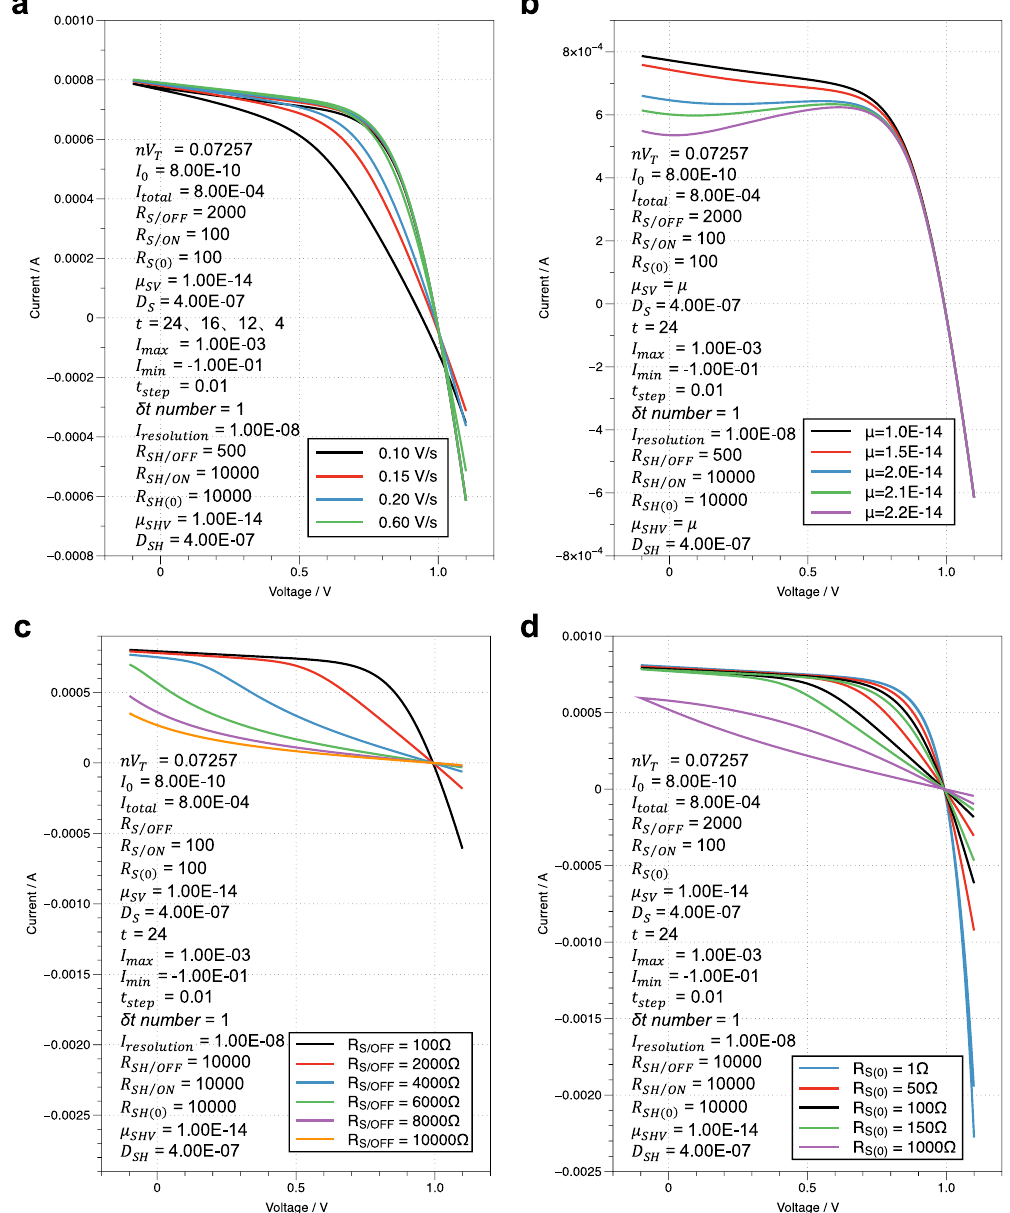
Figure 4. ( a ) The simulated/computed results of the dependence of the I–V characteristics of PSCs on voltage scan speed. ( b ) The simulated/computed results of the “bumping curve” phenomenon in the backward voltage scan. The “bumping curve” is realized by adjusting the values of µ SV and µ SHV , which are endowed with the same value for simplicity. ( c ) The simulated/computed results of the “inward curve” phenomenon in the forward voltage scan. The “inward curve” is realized by adjusting the R S / OFF value. The R SH is treated as an ohmic resistance for simplicity. ( d ) The simulated/computed results of the I–V characteristics of PSCs with different R S (0) . The R SH is treated as an ohmic resistance for simplicity. The specific values of all the parameters used in the simulation/computation are listed in the corresponding charts using SI